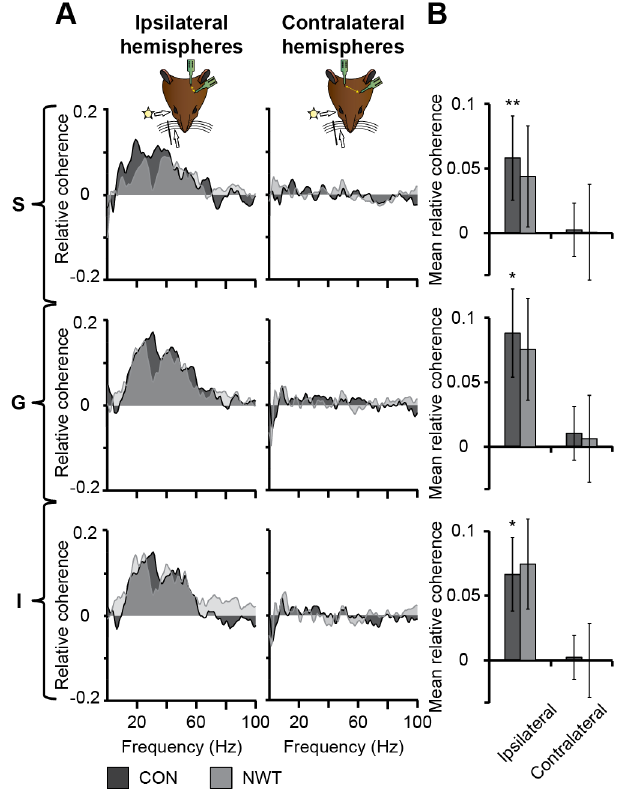
Fig 5. Coupling by synchrony and functional communication between S1 and V1 of CON and NWT rats. ( A ) Plots displaying the relative intra- (left) and interhemispheric (right) coherence change after bimodal stimulation between network activity in S (top), G (middle), and I (bottom) layers of the S1 and V1 of CON (black) and NWT rats (gray) in relationship to the frequency. The relative coherence was calculated by normalizing the values in all conditions to baseline (pre-stimulus) and subtracting unimodal coherence from the bimodal coherence. ( B ) Bar diagrams displaying the mean relative coherence between the layers of ipsi- and contralateral S1 and V1 when averaged for CON (black) and NWT rats (gray) in the frequency range of maximal coherence change (12 – 80 Hz). Significance values ( p < 0.05 [ * ], p < 0.01 [ ** ]) correspond to the comparison between uni- and bimodal stimulation conditions. The underlying data of this figure can be found in S1 Data.